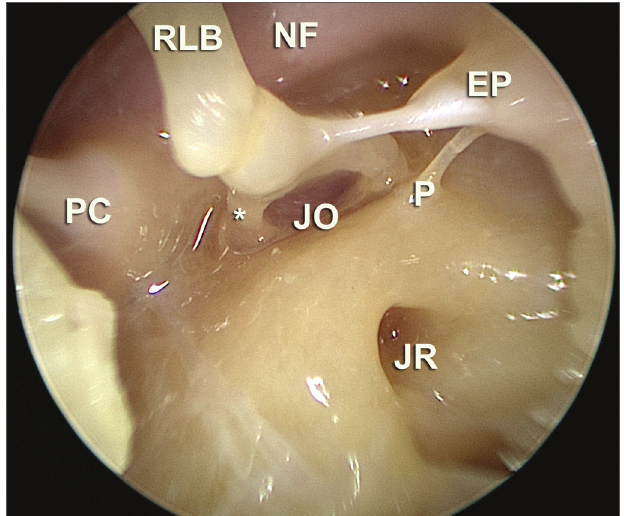
Figura 6. Imagem endoscópica de dissecção anatômica após a remo- ção timpânica, com instrumento de 30 graus de angulação, mostrando o tipo de imagem que pode ser obtida com acessos endoscópicos. Vemos os nichos da janela redonda (JR) e oval (JO), eminência pira- midal (EP), pontículo (P), canal do nervo facial (NF), ramo longo da bigorna (RLB) e articulação incudo-estapediana, além do processo cocleariforme (PC) e de praticamente todo o seio timpânico